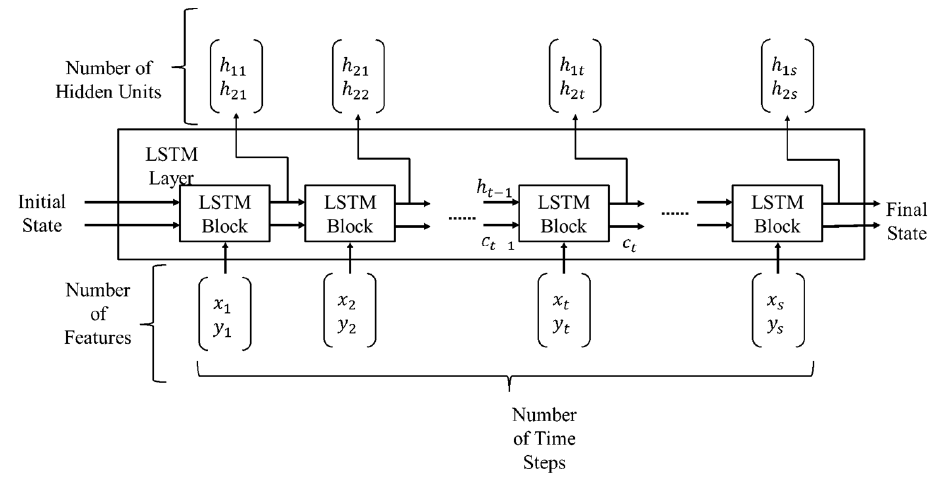
Figure 7. The architecture of LSTM layer.